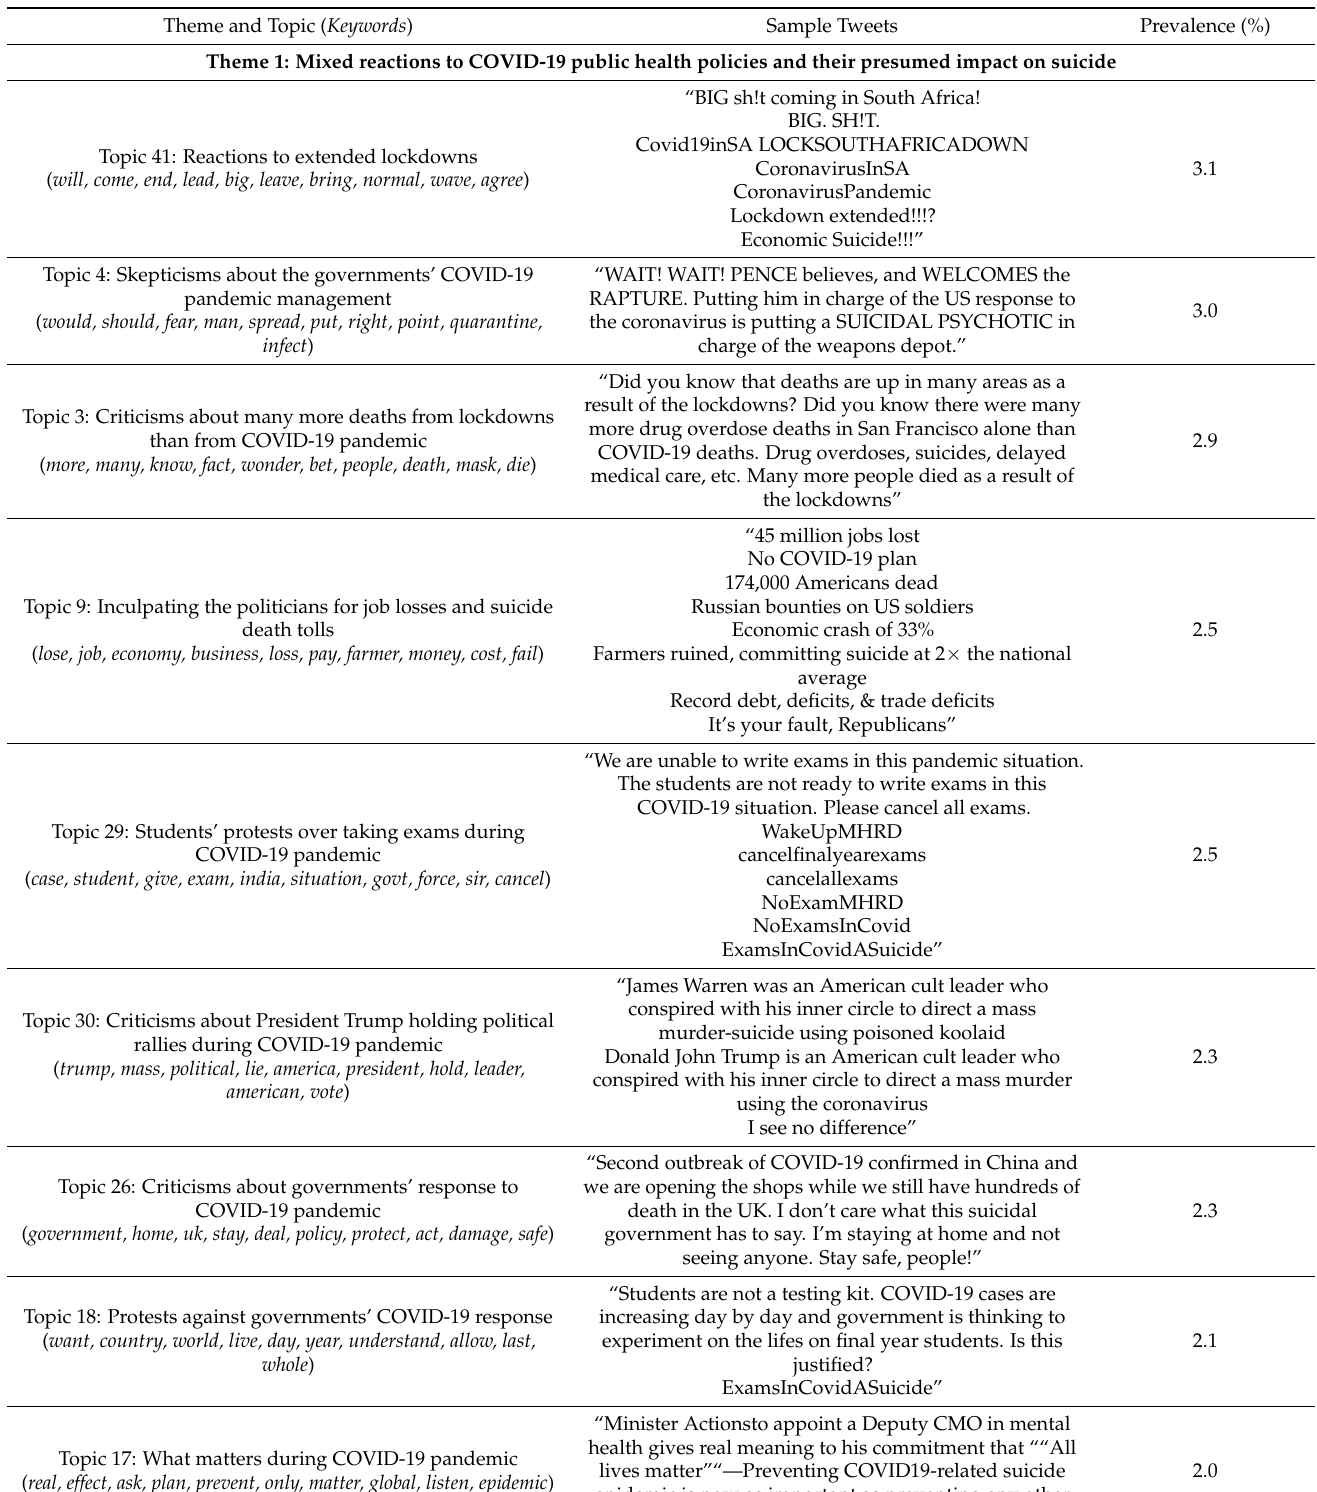
Table 1. The six themes on Twitter related to suicide, with its respective topic labels, sample tweets, and